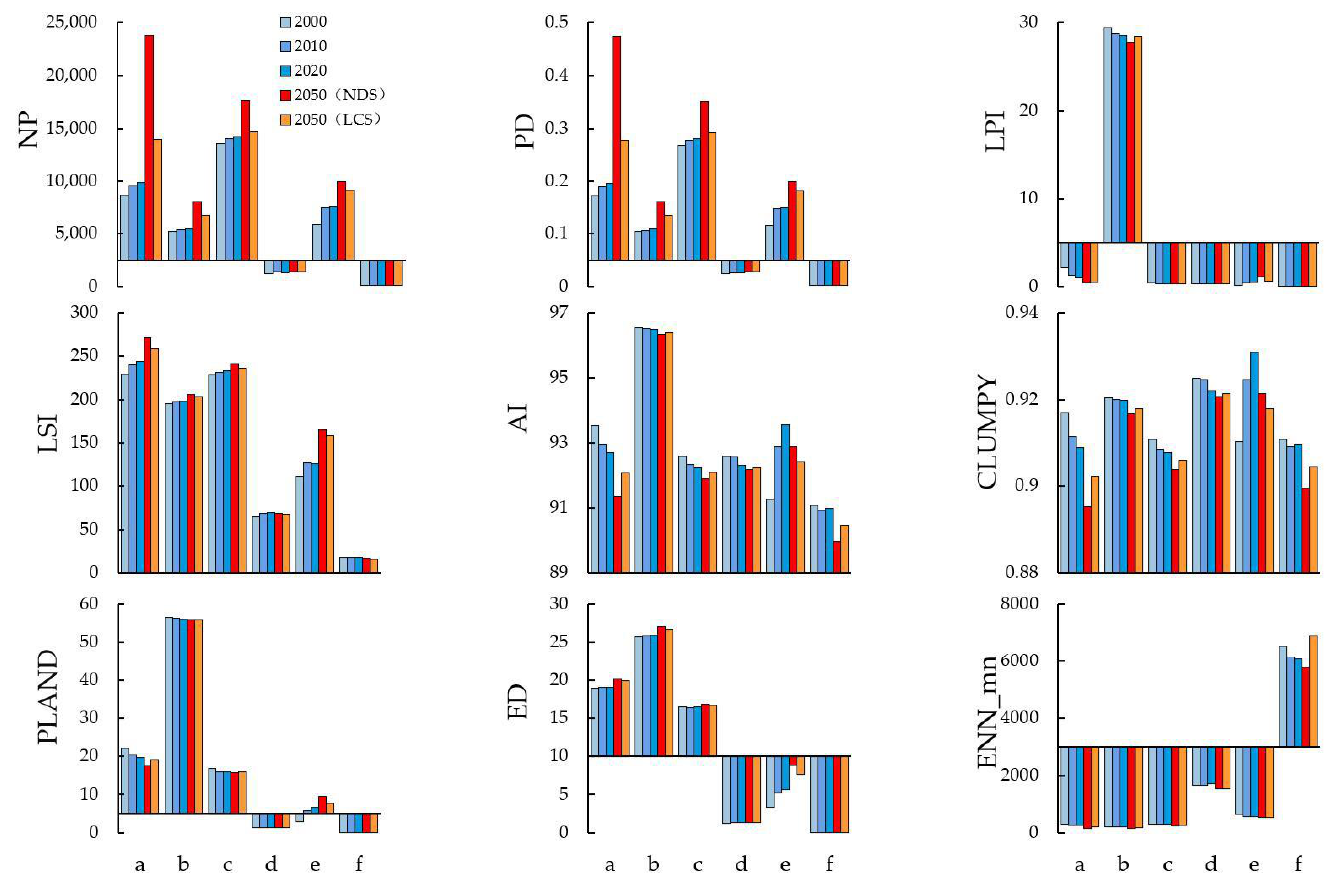
Figure 7. Landscape patterns index at landscape type level in Fujian coastal areas from 2000 to 2050. Abbreviations: a (cultivated land), b (woodland), c (grassland), d (water), e (construction land), f (unused land).